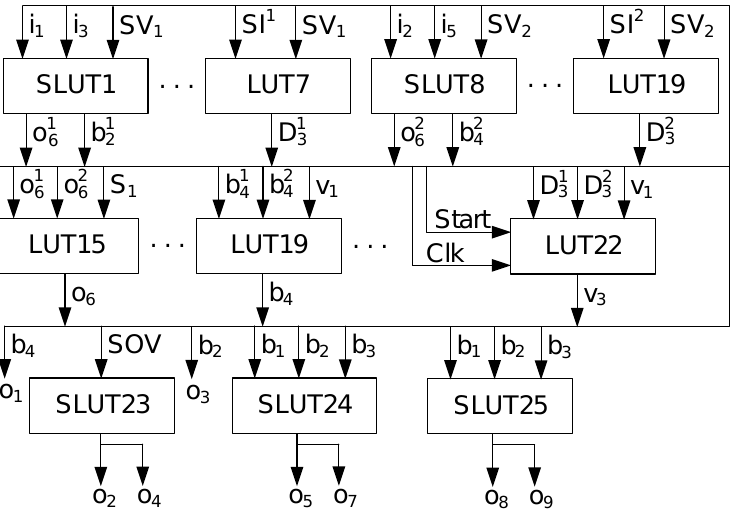
Figure 9. Logic circuit of FSM